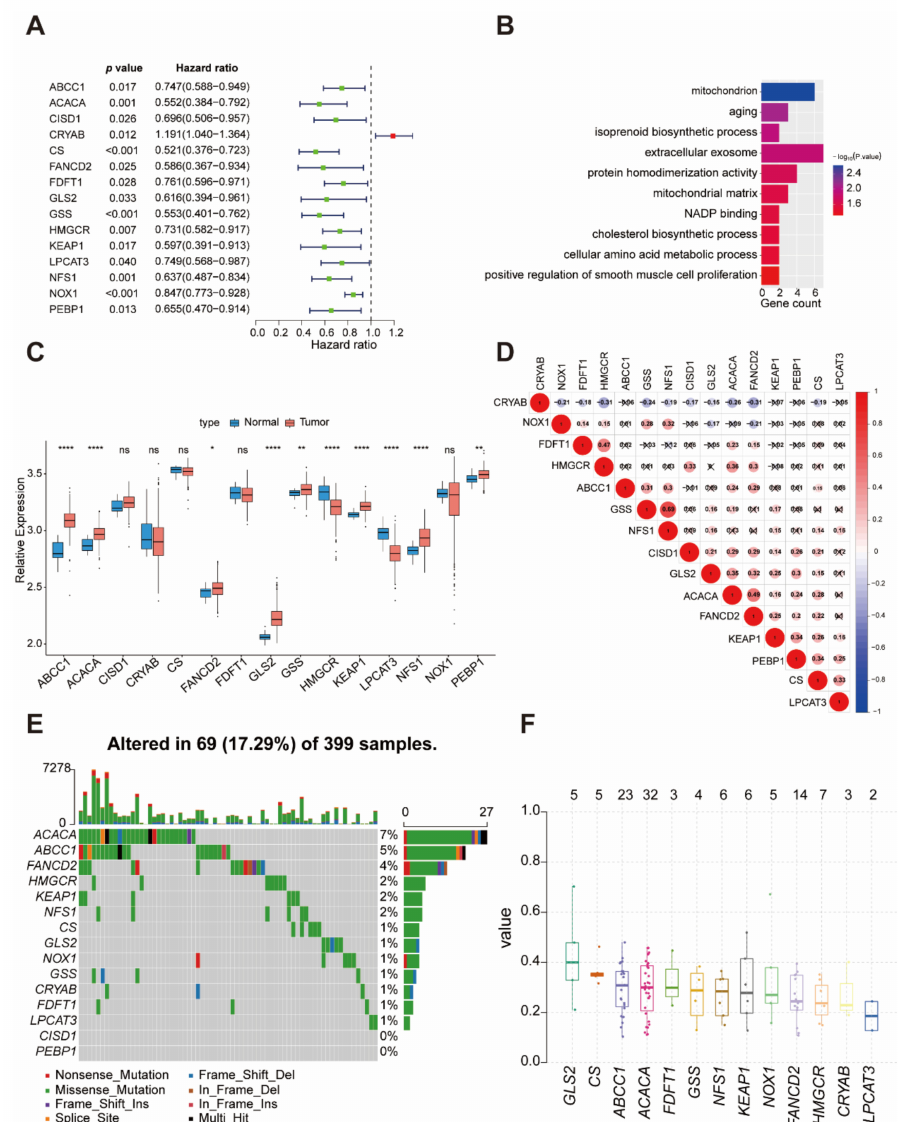
Figure 1. Landscape of genetic and expression variations of prognostic ferroptosis-related genes in colon cancer. ( A ) The prognostic analysis for ferroptosis-related genes in colon cancer using a univariable Cox regression model. ( B ) Functional annotation for 15 prognostic ferroptosis-related genes using GO enrichment analysis. ( C ) The expression of 15 ferroptosis- related genes between normal tissues and colon cancer tissues. Tumor, red; Normal, blue. The upper and lower ends of the boxes represent the interquartile range of values. The lines in the boxes represent median values, and the black dots show outliers. The asterisks represent the statistical p value (* p < 0.05, ** p < 0.01, **** p < 0.0001, ns means no significance). ( D ) The interaction between 15 ferroptosis-related genes in colon cancer. ( E ) The mutation frequency of 15 ferroptosis-related genes in 399 patients with gastric cancer from the TCGA-COAD cohort. Each column represents individual patients. The upper bar plot shows TMB. The number on the right indicates the mutation frequency in each regulator. The right bar plot shows the proportion of each variant type. The stacked bar plot below shows the fraction of conversions in each sample. ( F ) Variant allele frequency of 15 ferroptosis-related